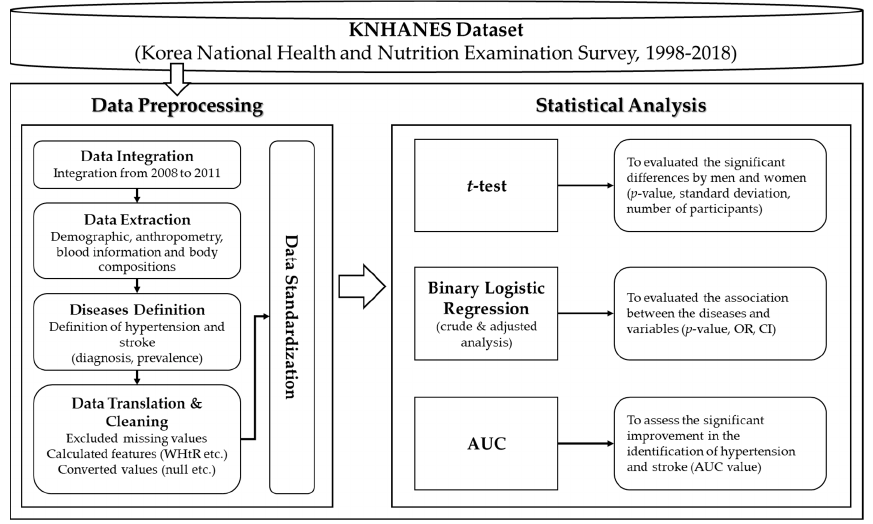
Figure 1. Design of experimental study for statistical analysis. WHtR, waist-to-height ratio; OR, odd ratio; CI, confidence interval; AUC, area under curve.